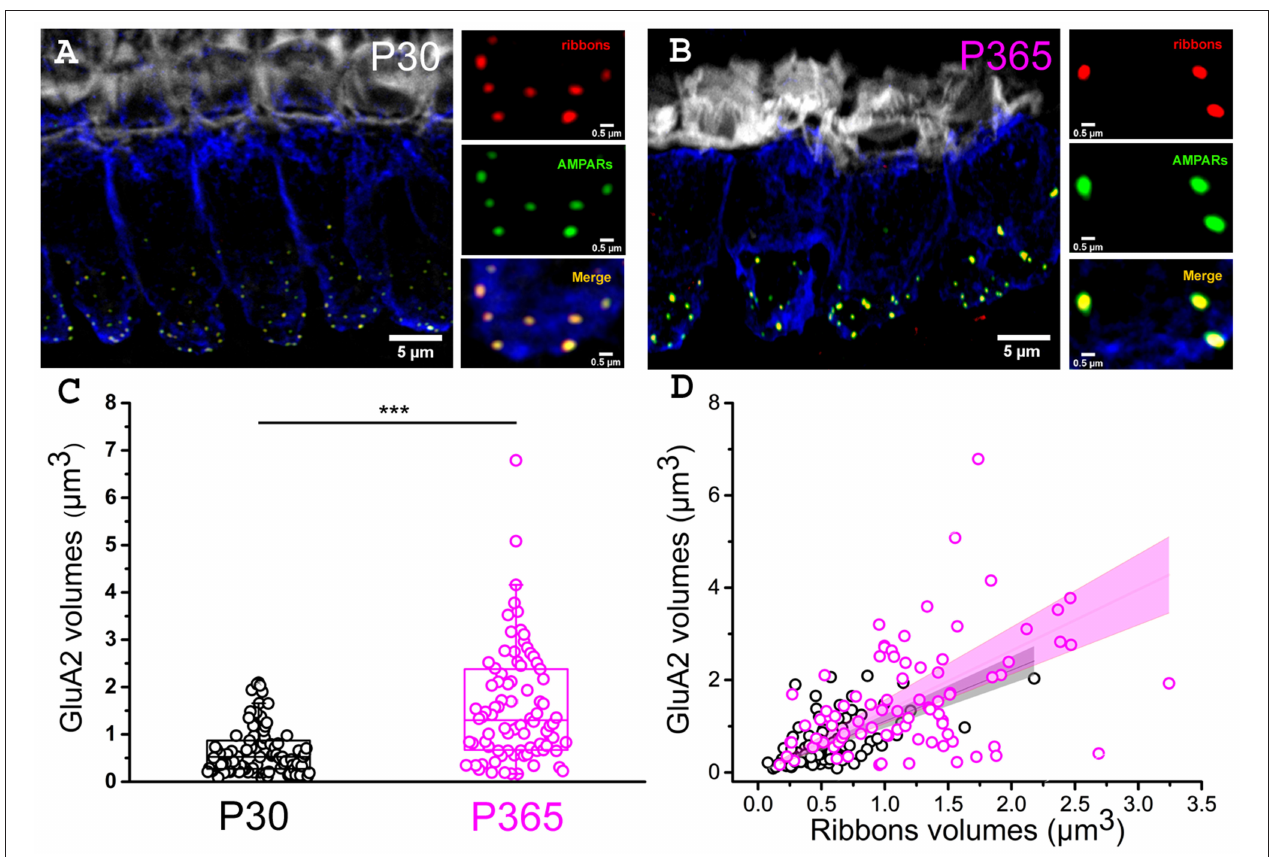
FIGURE 5 | Larger postsynaptic patches of GluA2 receptors in old IHCs. (A,B) Immuno-confocal imaging of IHCs (stack reconstructions of 22 slices of 0.3 µ m thickness) showing otoferlin (blue), the synaptic ribbons (Ribeye/CtBP2, red dots) and the post-synaptic AMPA receptors (GluA2, green dots). Fluorescent-phaloidin (gray) labeled F-actin in the strereocilia. The white bars indicate 5 µ m in (A,B) , then 0.5 µ m in the 3 small panels. (C) Comparative distribution of the volume of postsynaptic patches of AMPA GluA2 receptors. Note that the GluA2 receptor volume significantly increased with aging in C57Bl/6J mice ( p < 0.001; unpaired- t test); ( n = 86 synapses; from three mice at P30 (16 IHCs) and P365 (29 IHCs); mid-cochlear region encoding 8–16kHz). (D) Comparative volume distribution of postsynaptic GluA2 and corresponding postsynaptic ribbon in P30 and P365 IHCs. Note a good linear correlation between GluA2 and ribbon volumes (Pearson’s coefficient r = 0.93 and 0.86, respectively, for P30 and P360).